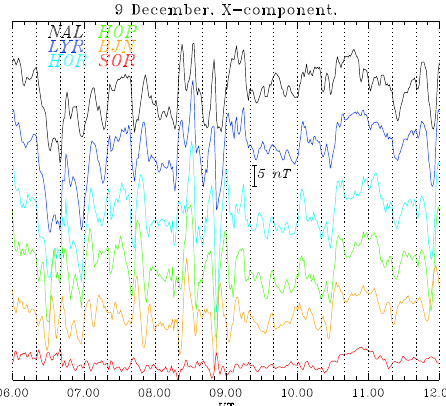
Figure 7. Magnetograms of the X component along the IMAGE profile from 06:00 to 12:00UT on 9 December 2001. Data from NRD are missing.